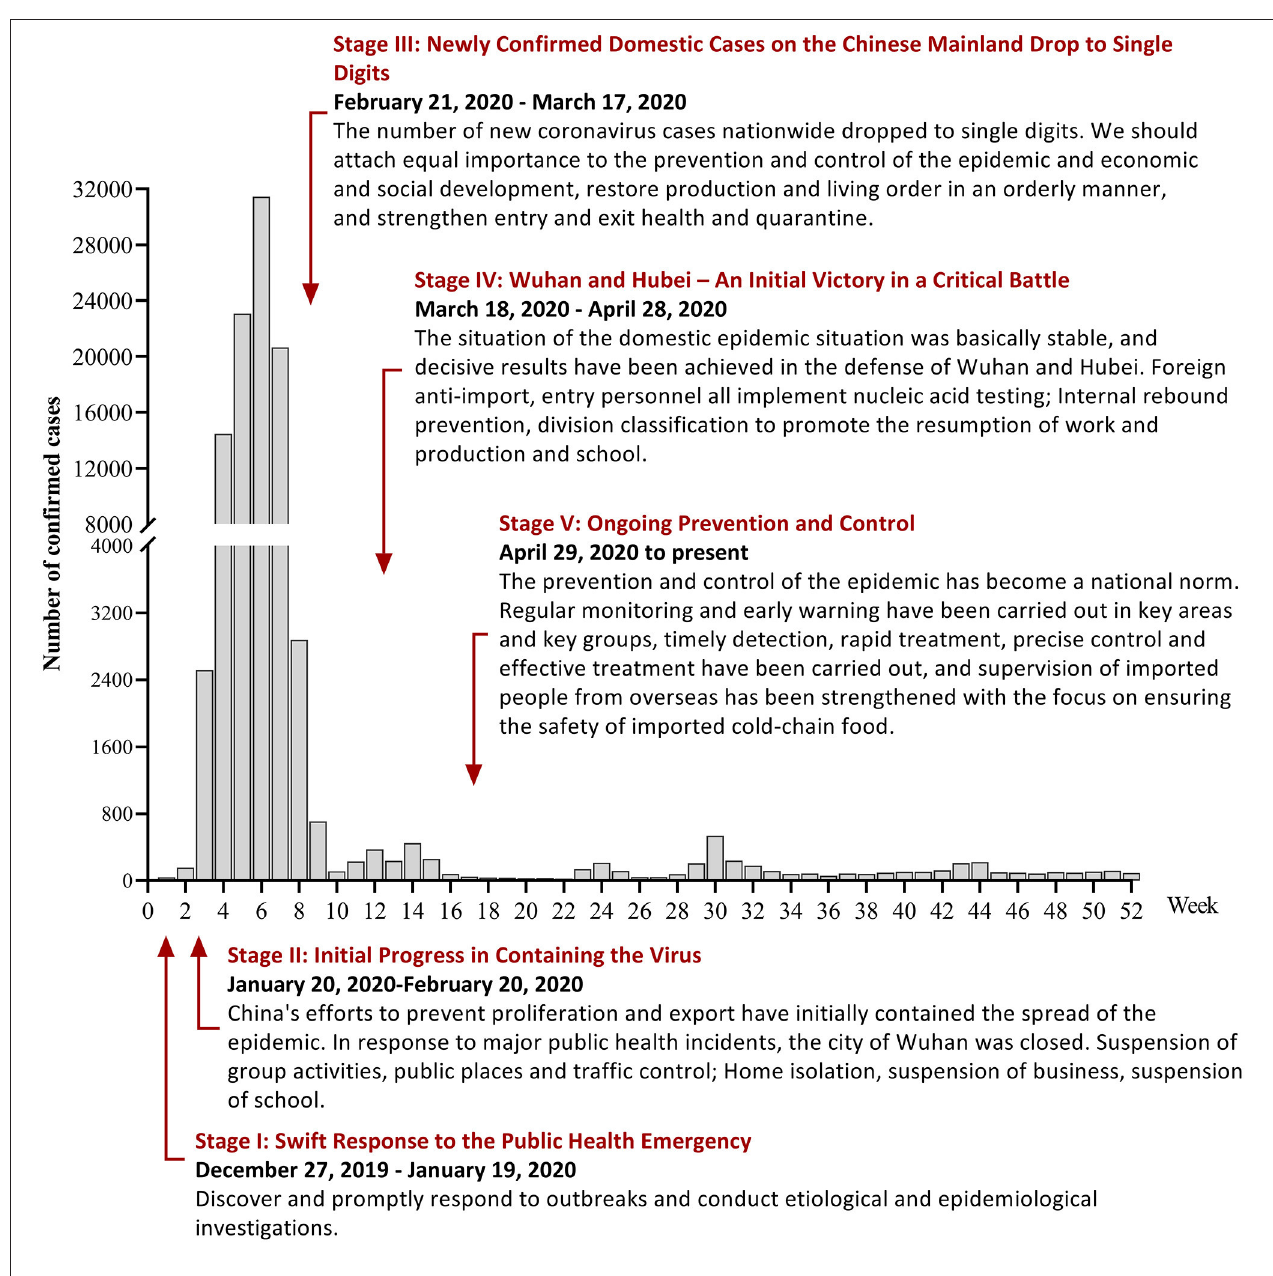
FIGURE 1 | Incidence and public interventions of COVID-19 in China in